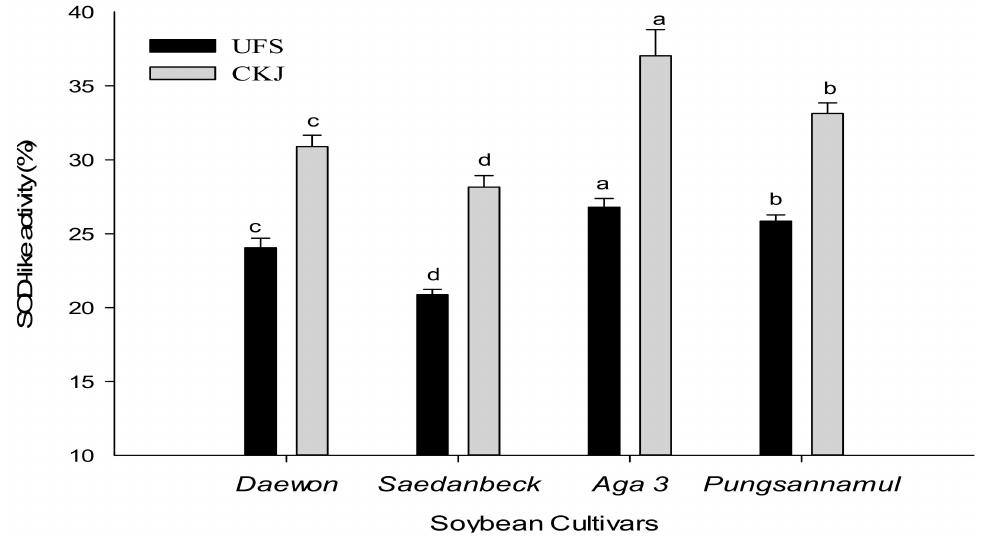
Figure 3. Changes in SOD-like activity between UFS and CKJ fermented by Bacillus subtilis (KCTC 13241) in different soybean cultivars. All values are means of three independent experiments. Means with different lowercase letters (a, b, c, and d) represent significant differences among cultivars by Duncan’s multiple range tests (DMRT) ( p <